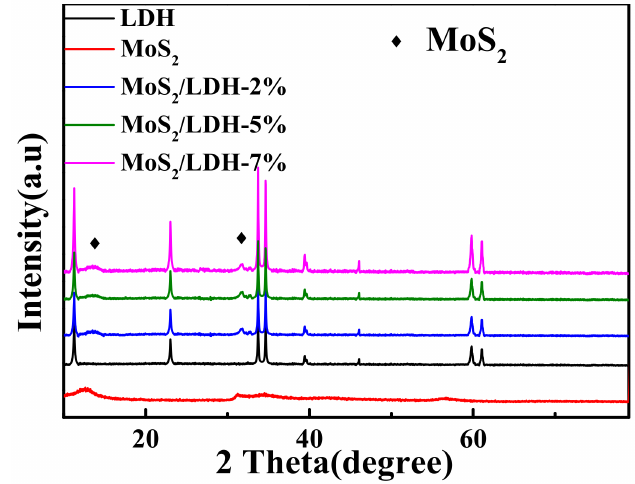
Figure 1. XRD patterns of all